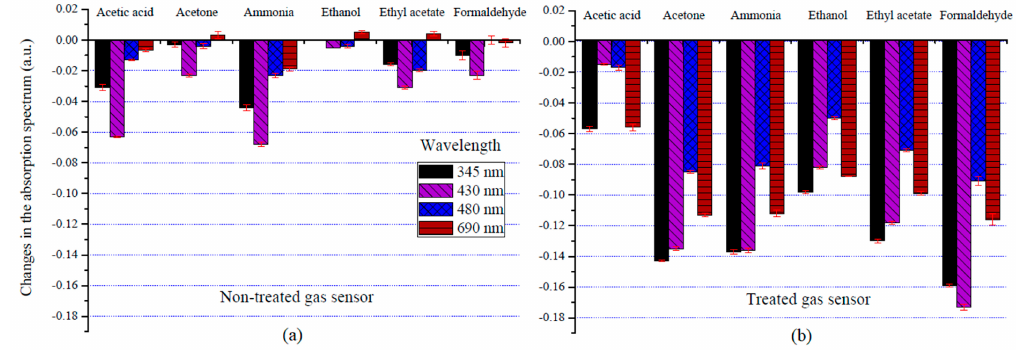
Figure 3. Changes in the absorption spectrum of ( a ) non-treated and ( b ) thermally treated gas sensors with different VOC profiles at wavelengths of 345, 430 480, and 690 nm.